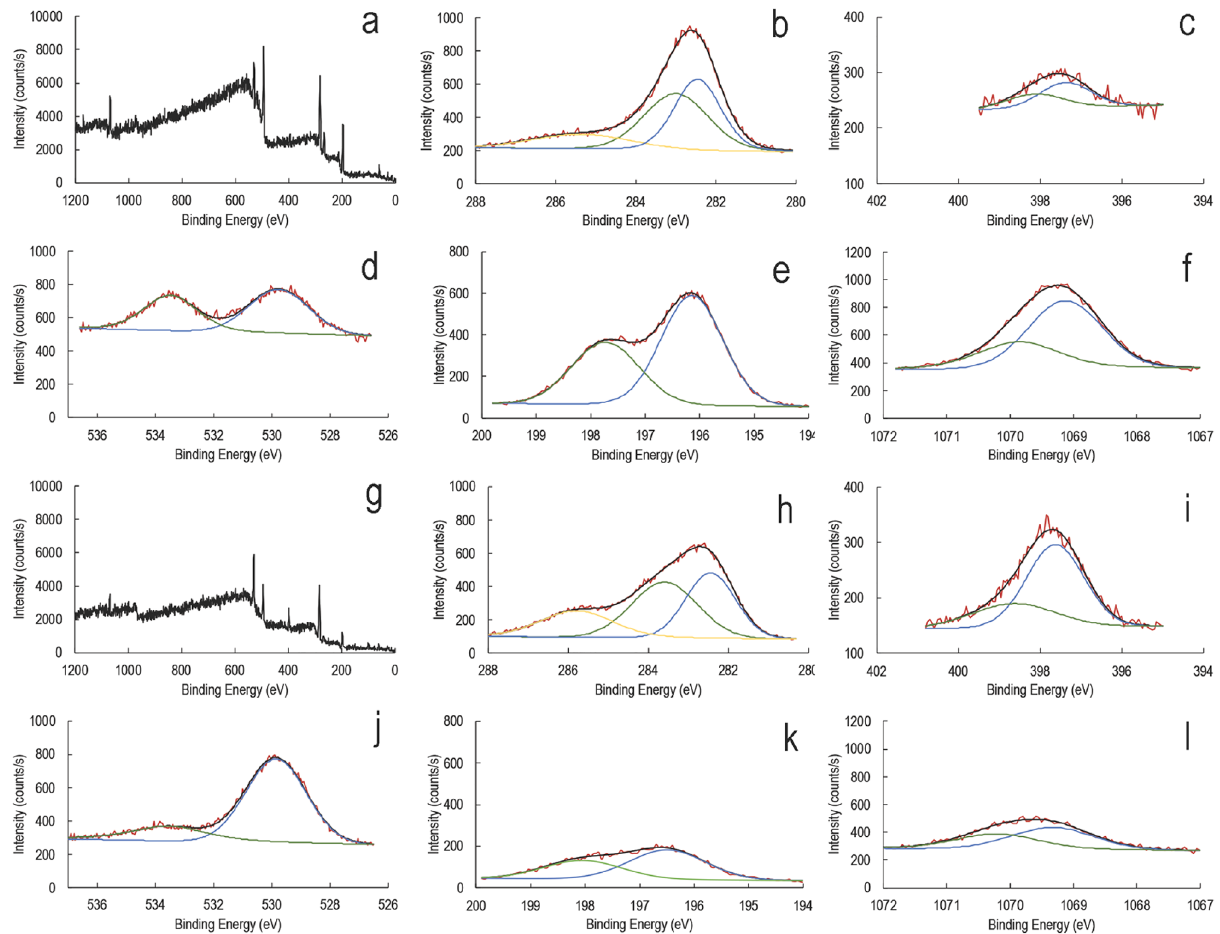
Figure 6. XPS spectrum to observe changes in silk cocoon surface composition upon interaction with NaCl. Blue, green, and yellow color XPS peaks code lowest to the highest binding energy. The corresponding binding energy values with respective color coding are available in Table 1. XPS for cocoon soaked in aqueous NaCl , ( a ) Survey spectrum, ( b ) C1s spectrum, ( c ) N1s spectrum, ( d ) O1s spectrum, ( e ) Cl2p spectrum, ( f ) Na1s spectrum; XPS spectra for cocoon soaked in aqueous NaCl and exposed to water vapor , ( g ) Survey spectrum, ( h ) C1s spectrum. ( i ) N1s spectrum, ( j ) O1s spectrum, ( k ) Cl2p spectrum, ( l ) Na1s